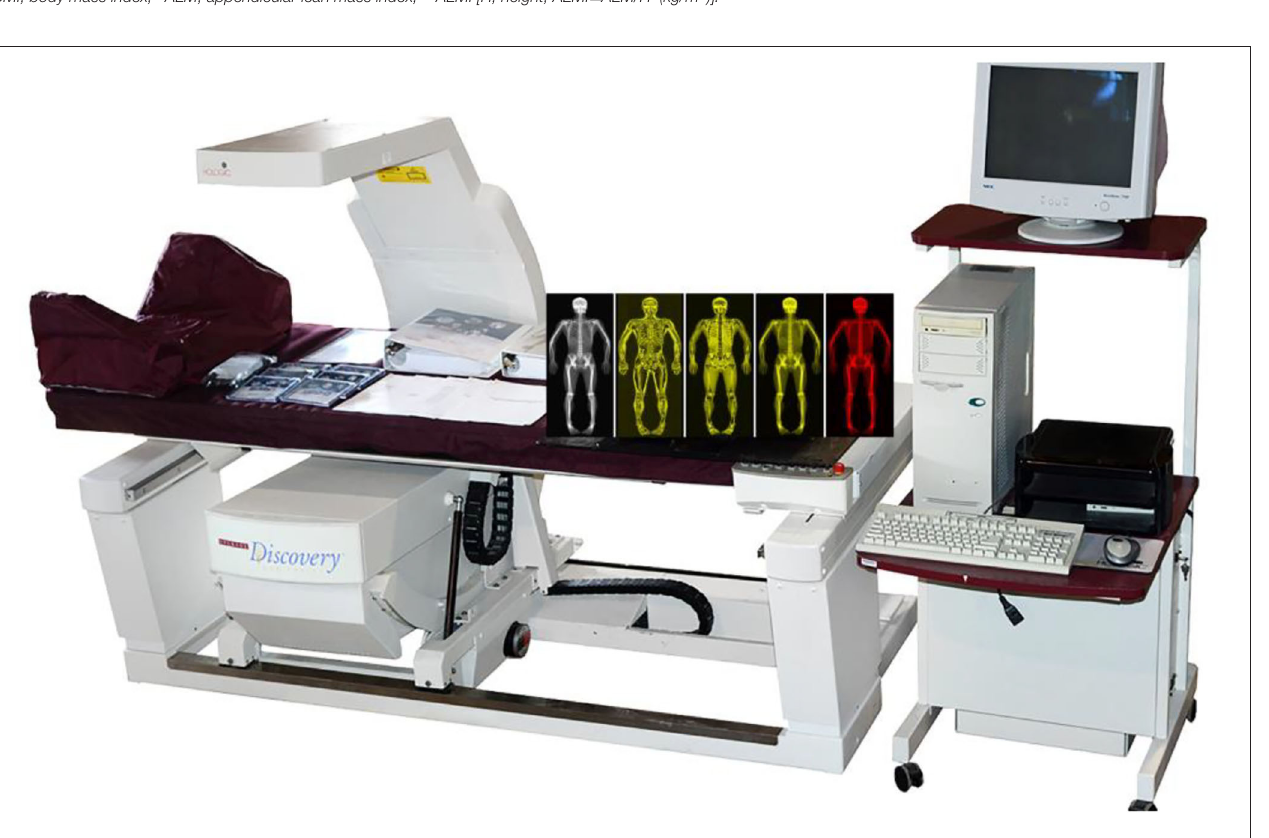
FIGURE 1 | A dual-energy X-ray absorptiometry (DXA) scanner (Hologic